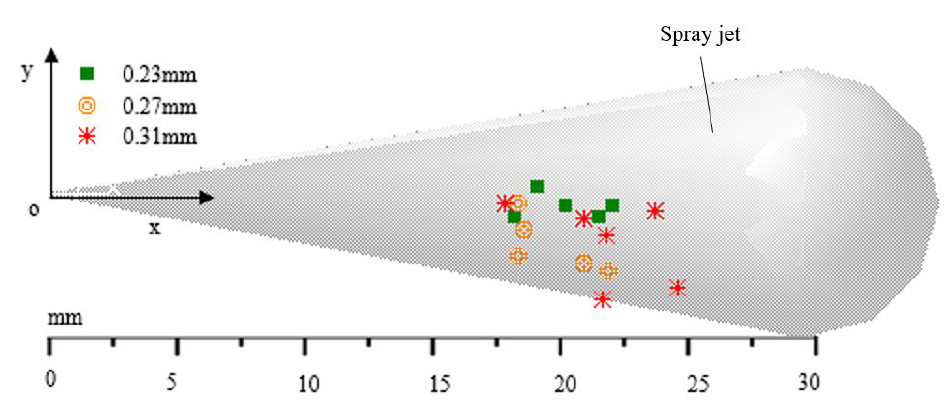
Figure 10. Axial initial occurring position of the ignition flame for different nozzle orifice diameters.